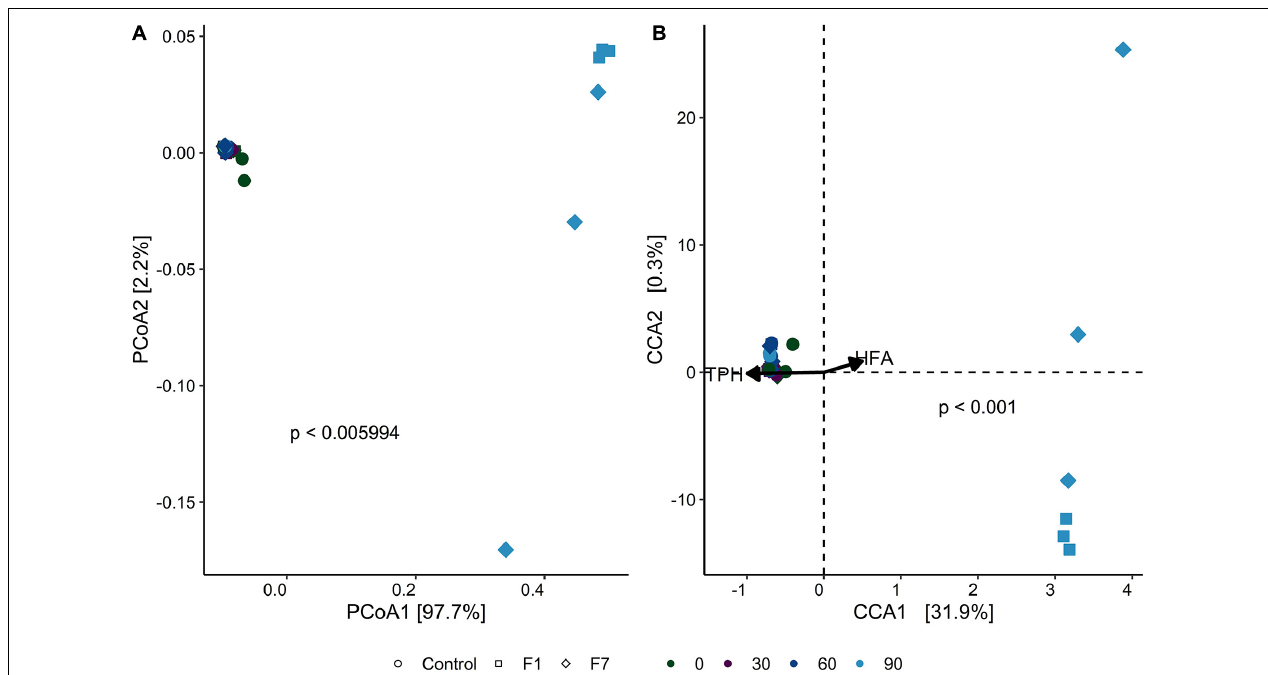
FIGURE 6 | (A) Principal component analysis (PCoA) of fungal communities, based on weighted UniFrac distance for each sample triplicate. Point shapes represent treatment category, while color indicates time category. The percentage reported on axes represent the amount of total variance depicted by each of them. P -value was calculated by ADONIS function (Vegan R package) between weighted UniFrac distances and sample groups, using the Bray–Curtis method with 1,000 repetitions. (B) Canonical correspondence analysis (CCA) biplot that shows correlation between ASV composition of each sample triplicate and the environmental parameters total petroleum hydrocarbon concentration (TPH) and humic and fulvic acid concentration (HFA). Point shapes represent treatment category, while color indicates time category. Black arrows are the eigen-vectors representing constraining variables. Eigen-values of constrained axes are 0.3952 for CCA1 and 0.0042 for CCA2. Of the total inertia, 32% is explained by CCA1 and CCA2 axes. Reported p -value is calculated by PERMANOVA test performed on full model ASV − TPH + HFA with 999